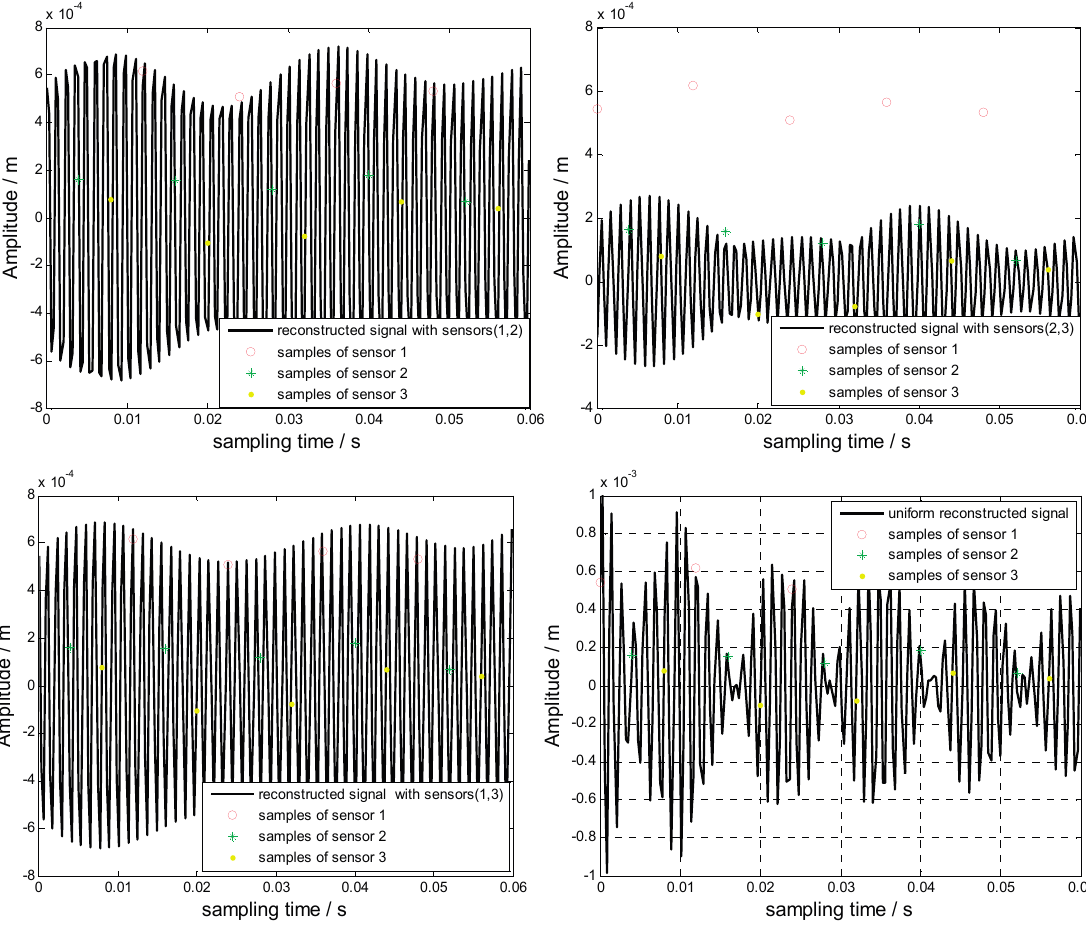
Figure 17. Reconstructed